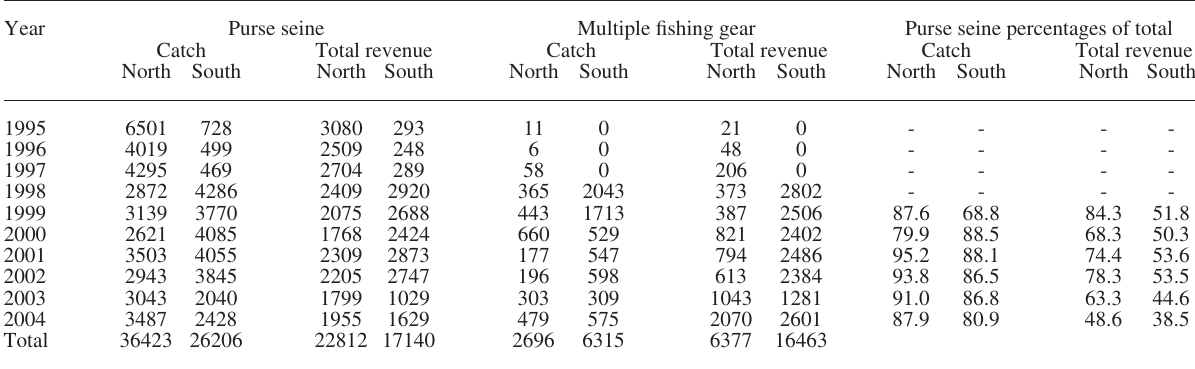
Table 1. – catch (t) and total revenue (thousands of €) of the fishing fleet for the interval 1995-2004. the relative importance of the catch and the total revenue (percentages of the total) corresponding to each fishing area (north and south) for each fleet are shown.